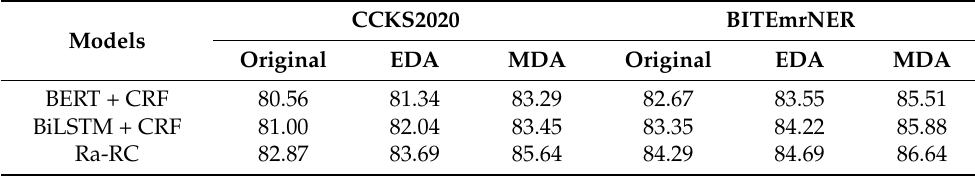
Table 5. F1-score of the NER task on the CCKS2020 dataset and the BITEmrNER dataset.